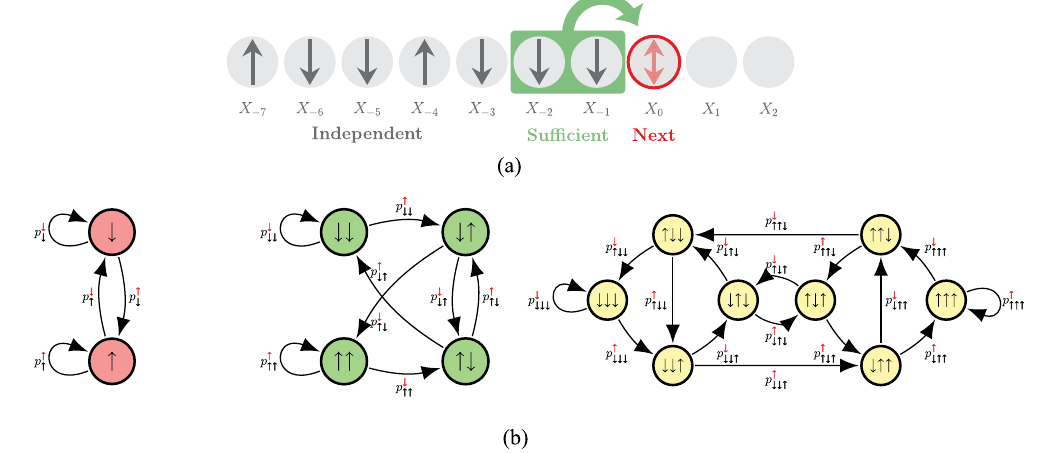
Figure 2. ( a ) A Markov order- N process generates a spin configuration from left-to-right. Markov order N = 2 shown. The values of an isolated spin X 0 , say, is undetermined. To make this (stochastic) choice consistent with the overall process and the particular instantiation on the left, it is sufficient to consider only the previous N (2) spins (highlighted in green). ( b )  -Machine generators of 1D-configuration stochastic processes in Dyson-Ising systems of increasing correlational complexity ( N = 1, 2, 3): T (1, )  (left), T (2, )  (middle) and  T (3, )